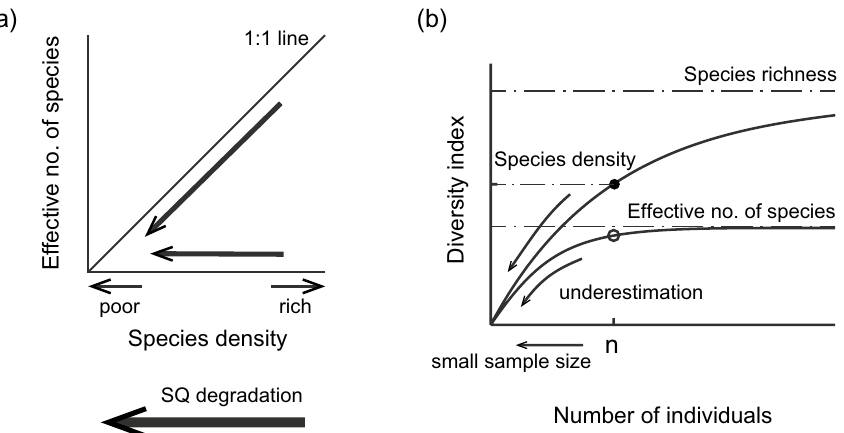
Figure 6. Two mechanisms that can affect the effective number of species (which can be estimated with Hill– Simpson diversity). ( a ) The effective number of species becomes lower at low species density with sufficient sample size. When the degradation of sediment quality (SQ degradation) affects species density but not the density of individuals, the effective number of species decreases as a real response to community structure. However, as shown in ( b ), the effective number of species also becomes lower at small sample size n . When SQ degradation affects the density of individuals, the effective number of species might not reflect a real response in community